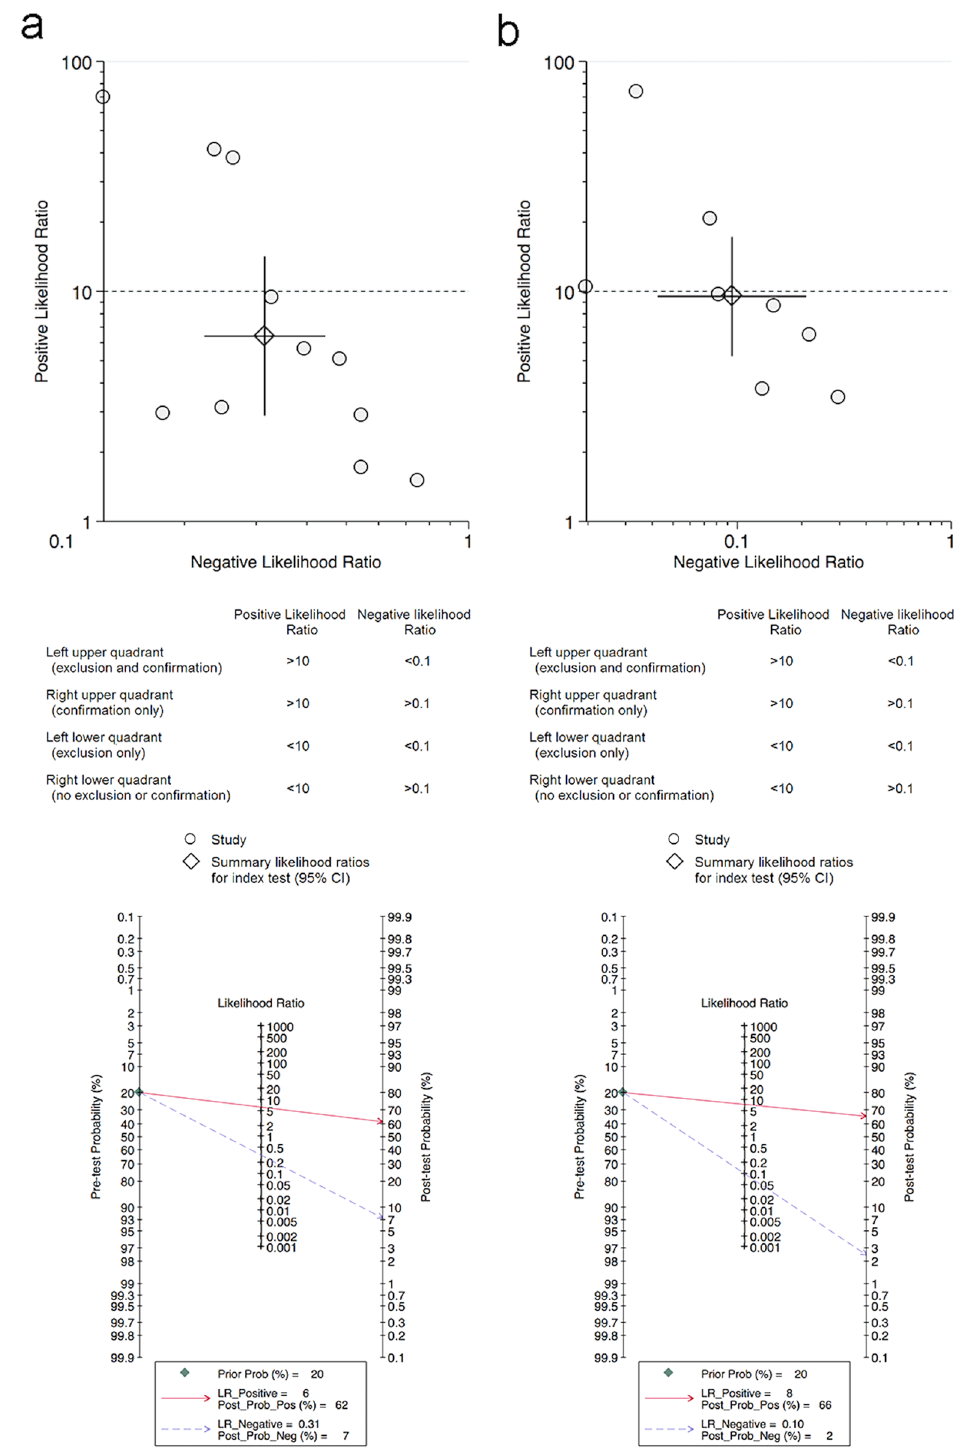
Figure 3. Likelihood ratio scatter diagrams and post-test probabilities for serum ( a ) and synovial fluid IL-6 ( b